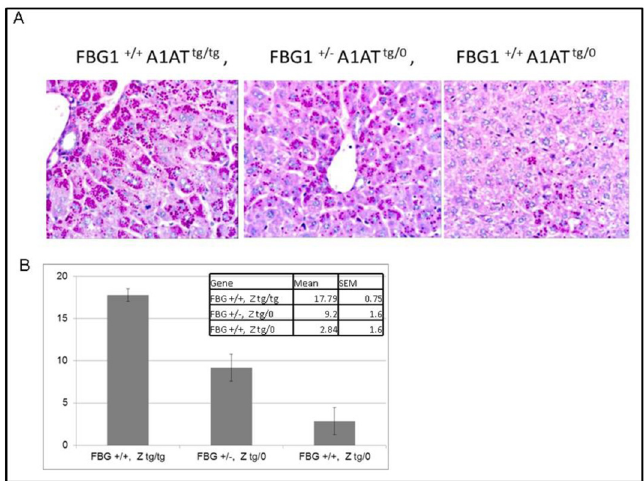
Fig 4. FBG1 knockout increases A1AT-Z dPAS accumulation in the mouse liver. FBG1 knockout mice (FBG1 -/- ) were crossed with mice with the A1AT-Z transgene (A1AT-Z tg/tg ). Livers were harvested from 6 month old mice of FBG1 +/+ A1AT-Z tg/tg (n = 3), FBG1 +/- A1AT-Z tg/0 (n = 6), and FBG1 +/+ A1AT-Z tg/0 (n = 3), sectioned and stained with H&E and dPAS. A) There was more dPAS staining in FBG1 +/0 A1AT-Z tg/0 mice than in FBG1 +/+ A1AT-Z tg/0 mice. B) dPAS staining occupied 9.2% of the cell area in FBG1 +/0 A1AT-Z tg/0 compared to 2.8% in the FBG1 +/+ A1AT-Z tg/0 .